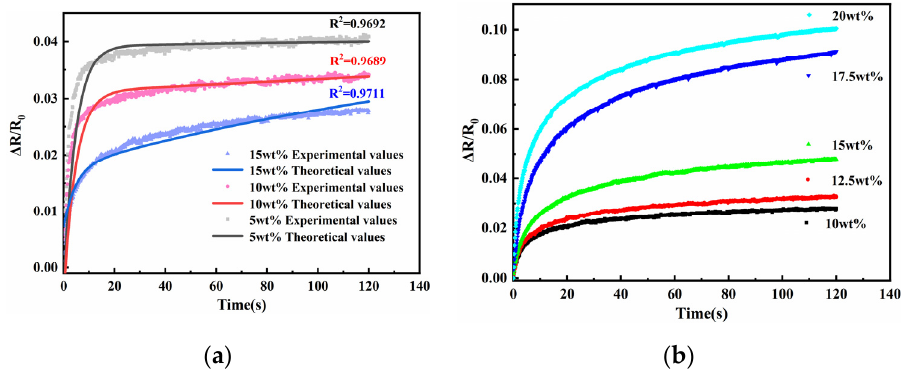
Figure 9. The effect of the mass fraction on the creep resistance of polymer at a constant ratio of nickel to graphene. ( a ) Small mass fraction resistance creep curve of the sensing unit. ( b ) Large mass fraction resistance creep curve of the sensing unit.